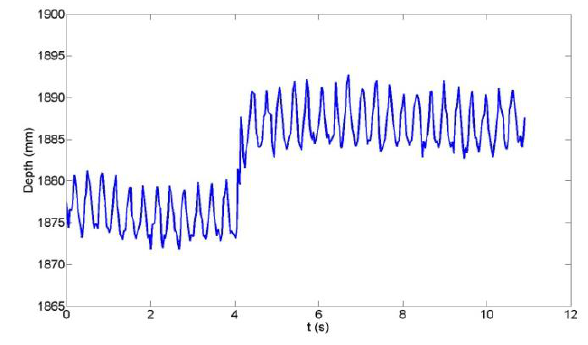
Figure 6. Computed witness plate centroid depth measurement .